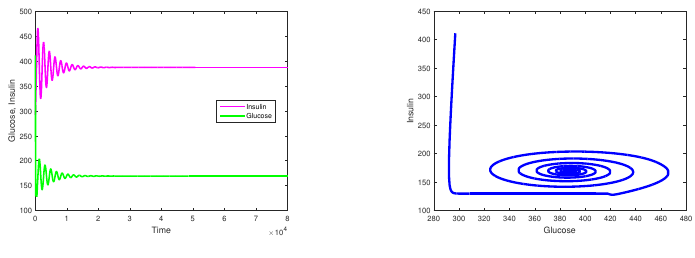
Figure 13. Glucose-insulin dynamics: dynamics and phase plain for τ i = 450 < τ ∗ = 500 min. i